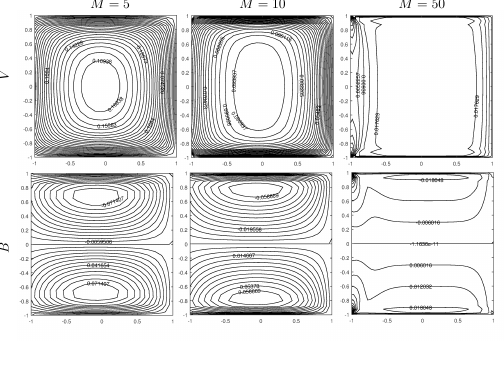
Figure 4. Velocity and induced magnetic field from inverse solution, β = 0.